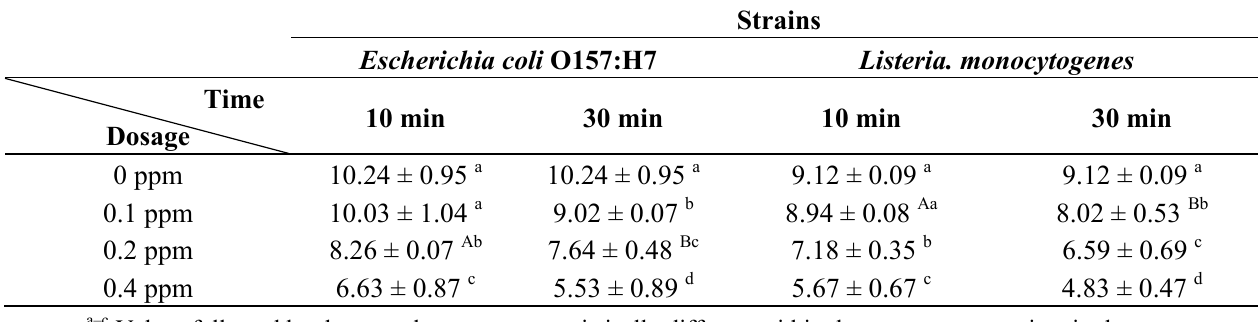
Table 3. Mean (standard deviation) bacterial counts in log cfu/mL of E. coli O157:H7